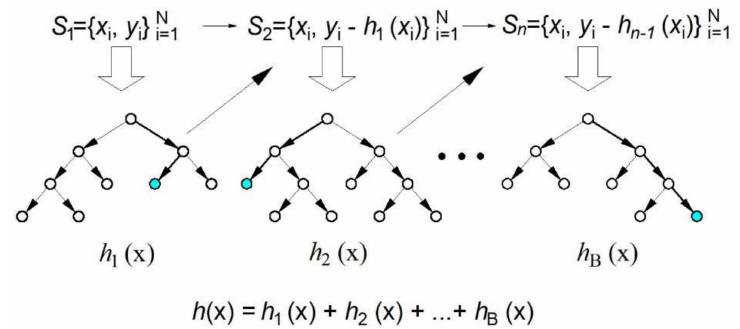
Figure 6. Gradient boosting in regression tree ensembles [25].